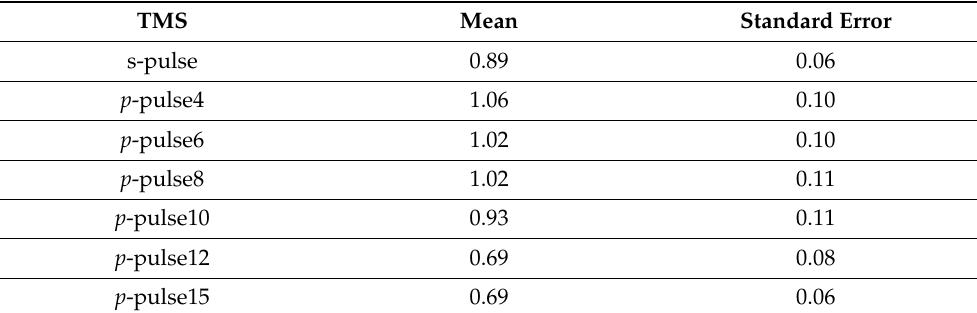
Table 1. Mean values and standard error of the MEP amplitude in the different TMS